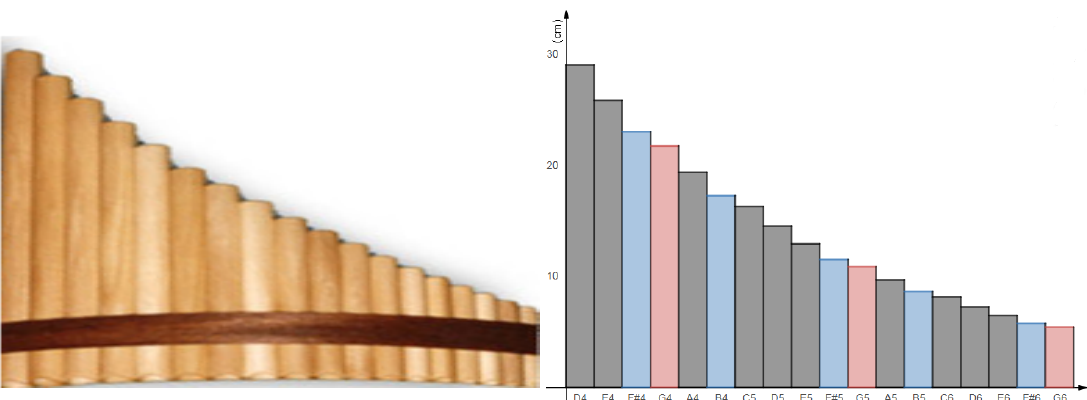
Figure 1. An 18-pipe Pan’s flute tuned in G-major and a bar graph representing the lengths of individual pipes in cm. The red bars show the root notes (in this case G’s), the gray bars show the location of whole tone intervals, and the blue bars show the location of semitone intervals.